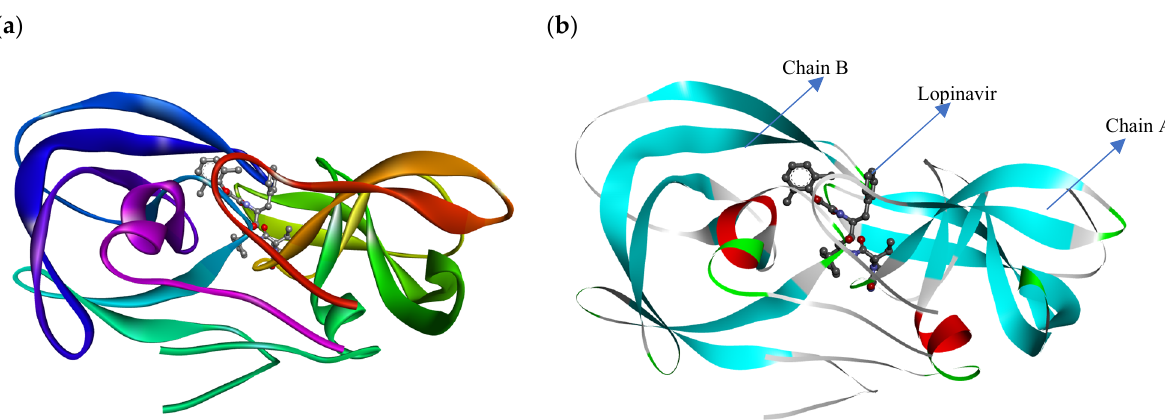
Figure 6. The 3D structure of 2Q5K for molecular modeling: ( a ) publication quality representation, ( b ) flat ribbon representation (all prepared using Discovery Studio Visualization vs21.1.0.20298).